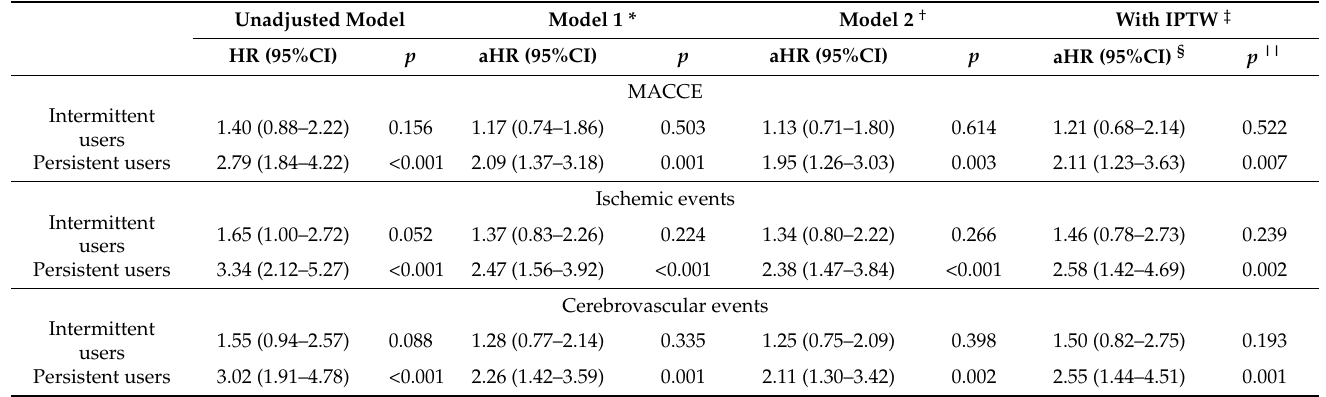
Figure 2. Cumulative incidence of aspirin groups and each end-point event assessed by Kaplan– Meier curves. Annotation: ( A ) MACCE; ( B ) ischemic Events; ( C ) cerebrovascular events; ( D ) cardiac events; ( E ) revascularization; ( F ) cerebral infarction. MACCE, major adverse cardiovascular and cerebrovascular events. Table 2. Association between aspirin groups and different end point events in Cox proportional hazards